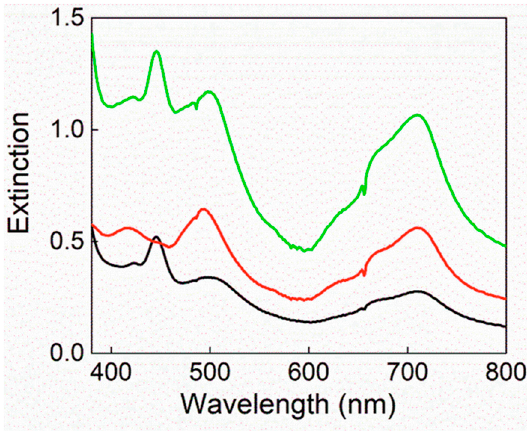
Figure 2. Extinction spectra of s-PEEK/TPPS composite membranes re-cast from DMAc 0.35 wt % TPPS (black line), s-PEEK-0.77 (red line) and s-PEEK-1.5 (green line) at 25 °C.